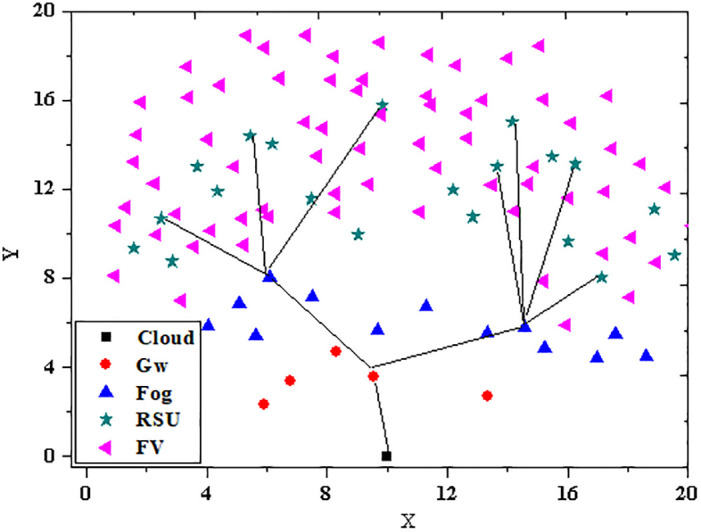
ND analysis of Scenario C.